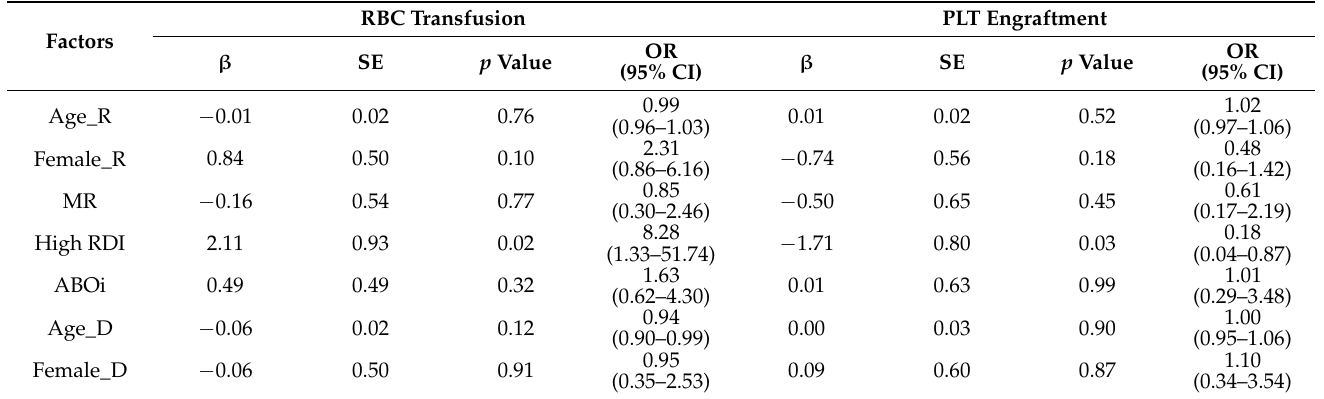
Table 4. Risk factors for RBC transfusion and PLT engraftment, determined using multivariate logistic regression analysis.